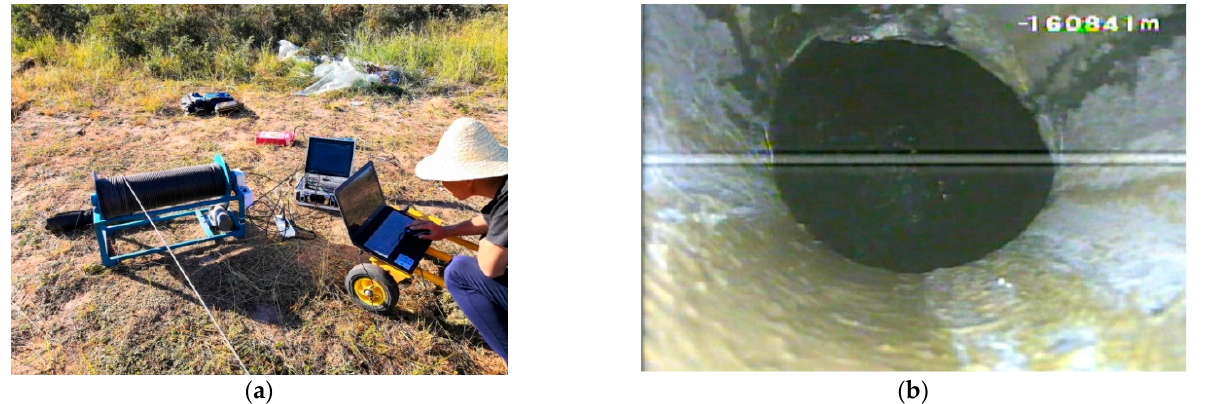
Figure 12. Live peep operations [30 – 32] . ( a ) Daily observations, ( b ) Goaf peep results. When the goaf is filled with backfill material, the borehole television cannot be